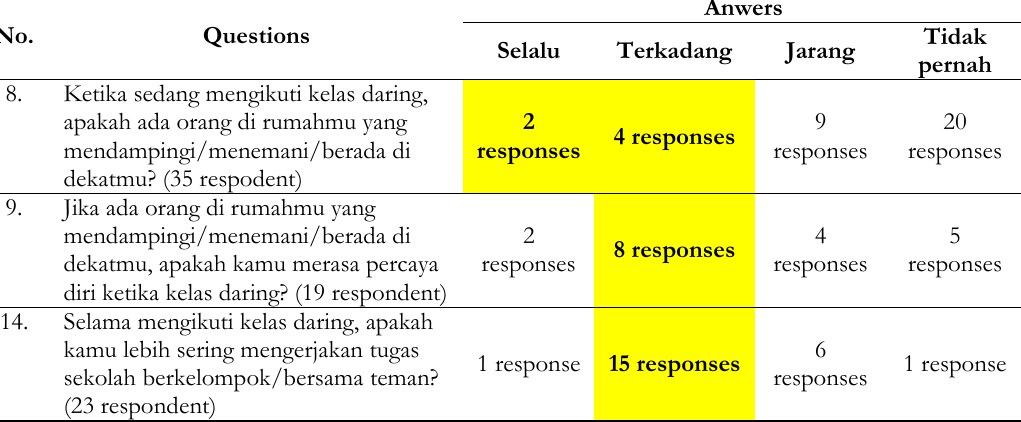
TABLE 4. The 3 rd Topic of the